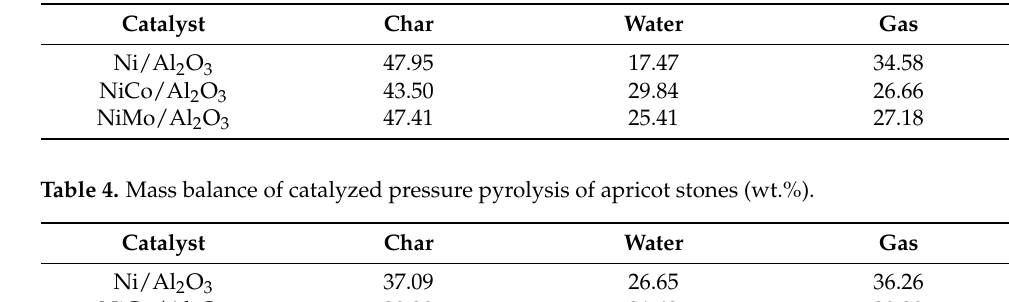
Table 3. Mass balance of catalyzed pressure pyrolysis of birch shavings (wt.%).